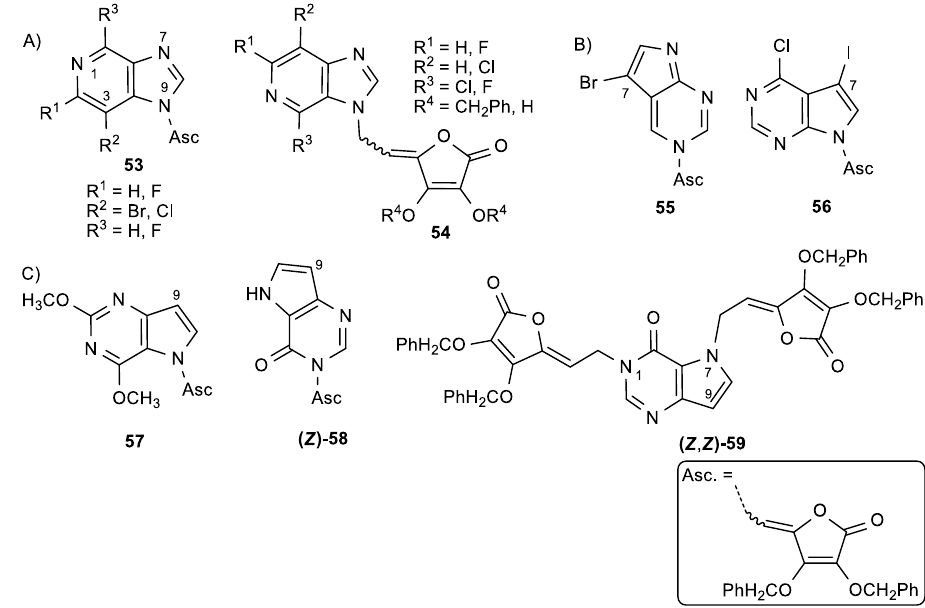
Figure 23. ( A ) 3-Deazapurine derivatives of ASA, ( B ) 7-deazapurine derivatives of ASA, and ( C ) 9-deazapurine derivatives of ASA. Table 22. The cytostatic activities of 9-deazapurine ASA derivatives. Comp.